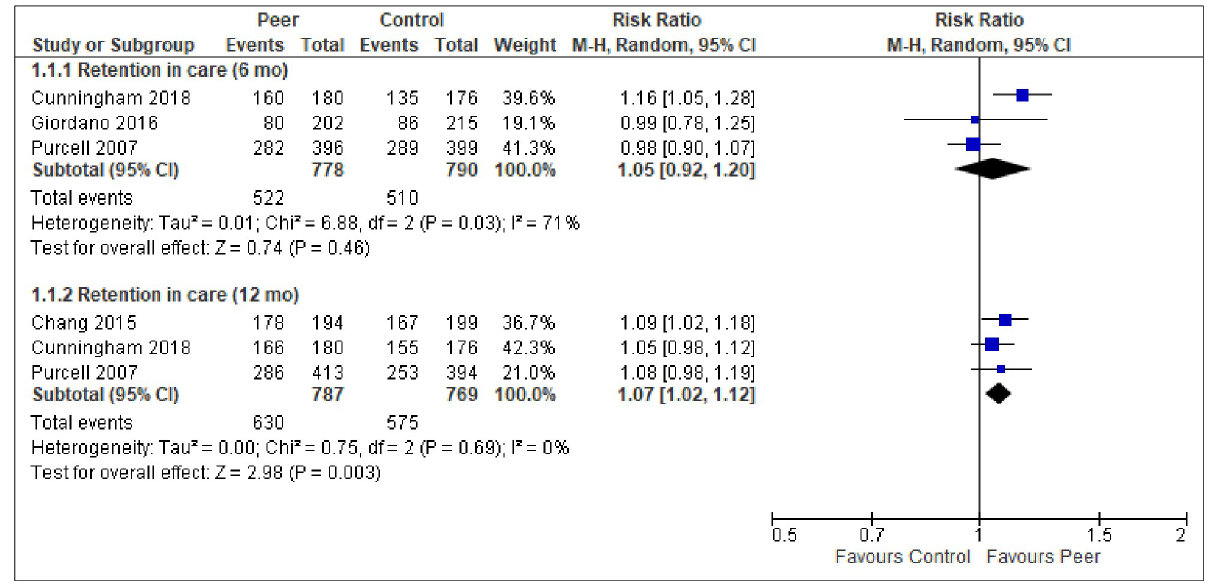
Fig 3. Meta-analyses of outcome retention in care.